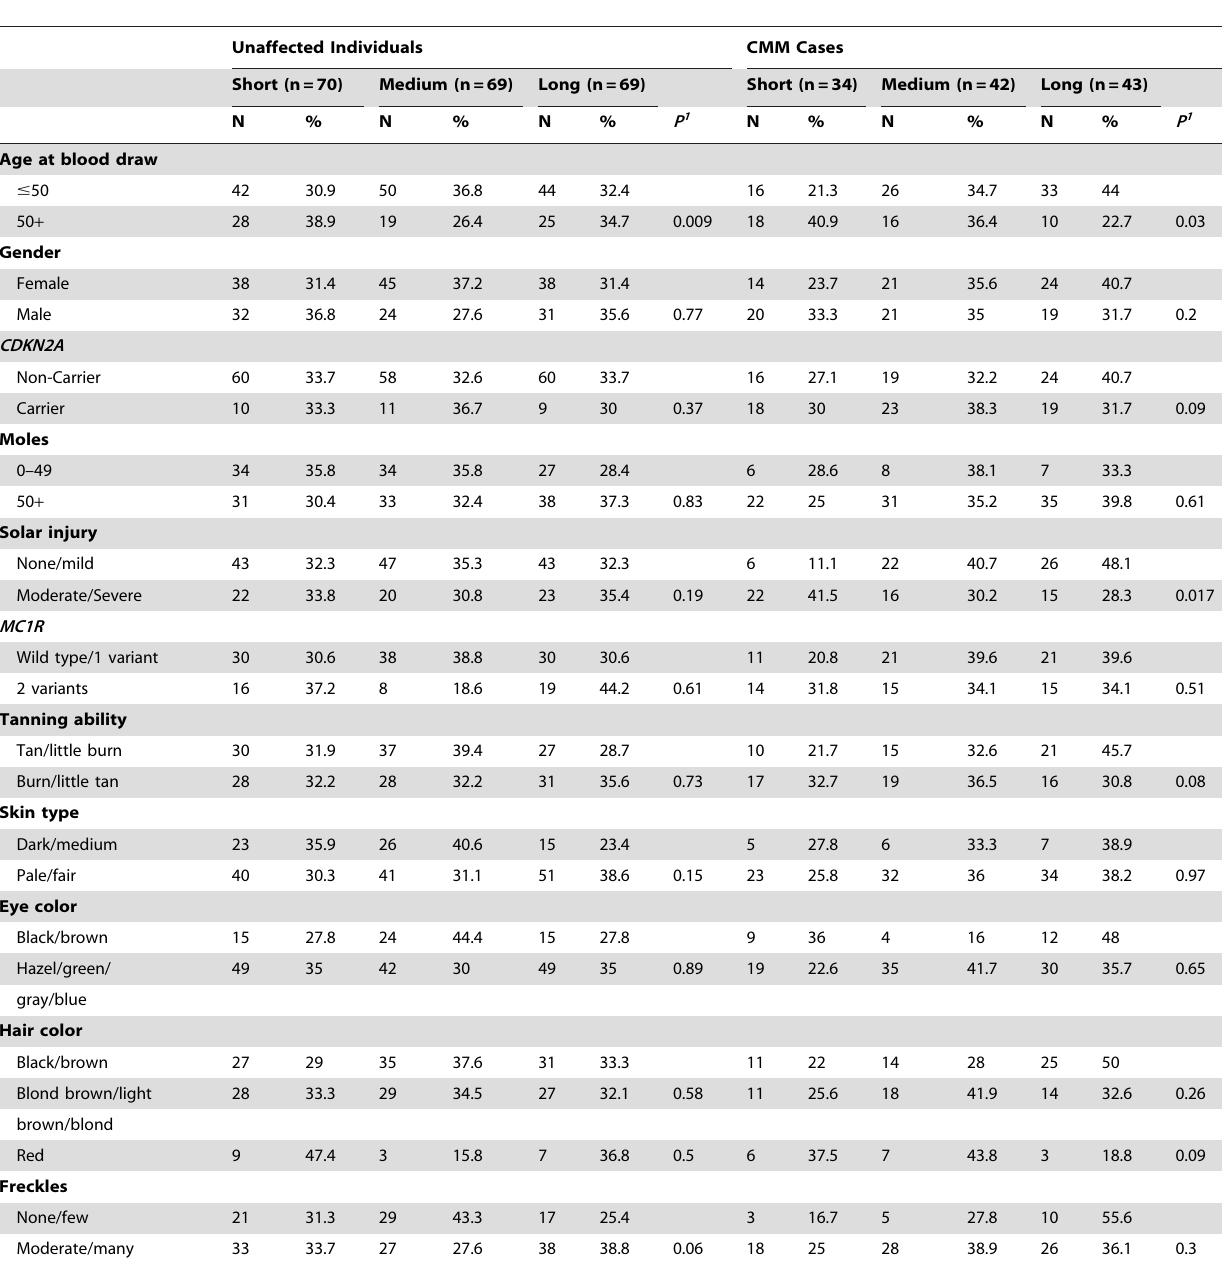
Table 2. Distribution of age, gender, CDKN2A , pigmentation phenotype, and sun exposure variables in 53 melanoma-prone families by telomere length, stratified by CMM